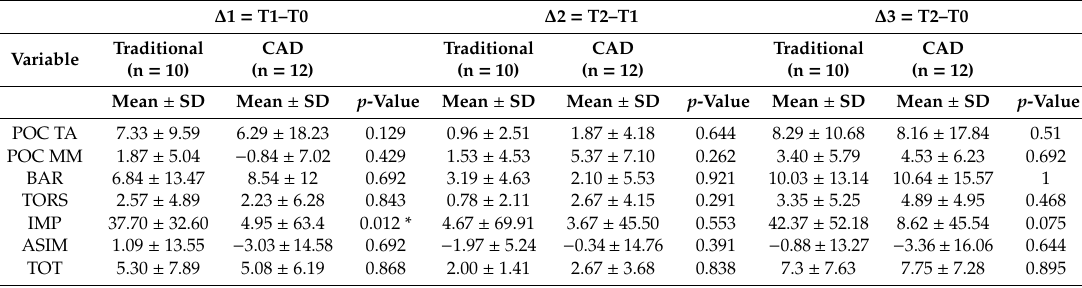
Table 4. Di ff erences between the two groups (traditional, digital) at di ff erent time gaps ( ∆ 1, ∆ 2, ∆ 3). ∆ 1 = T1–T0 ∆ 2 = T2–T1 ∆ 3 = T2–T0